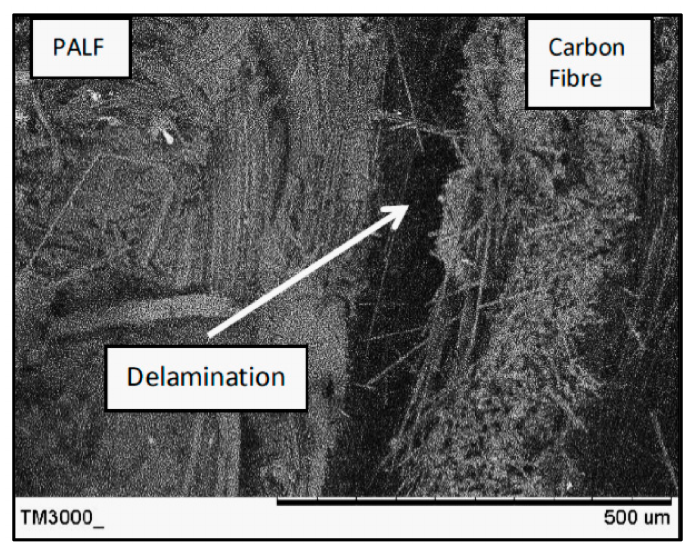
Figure 9. SEM image of CPPC_45090 at a 45% UTS ratio.